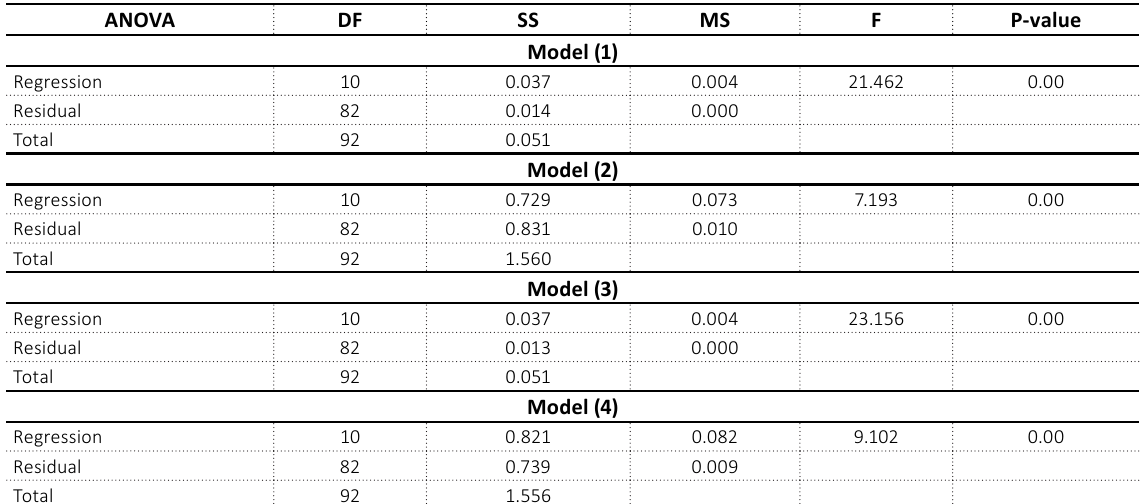
Table 4. Analysis of variance